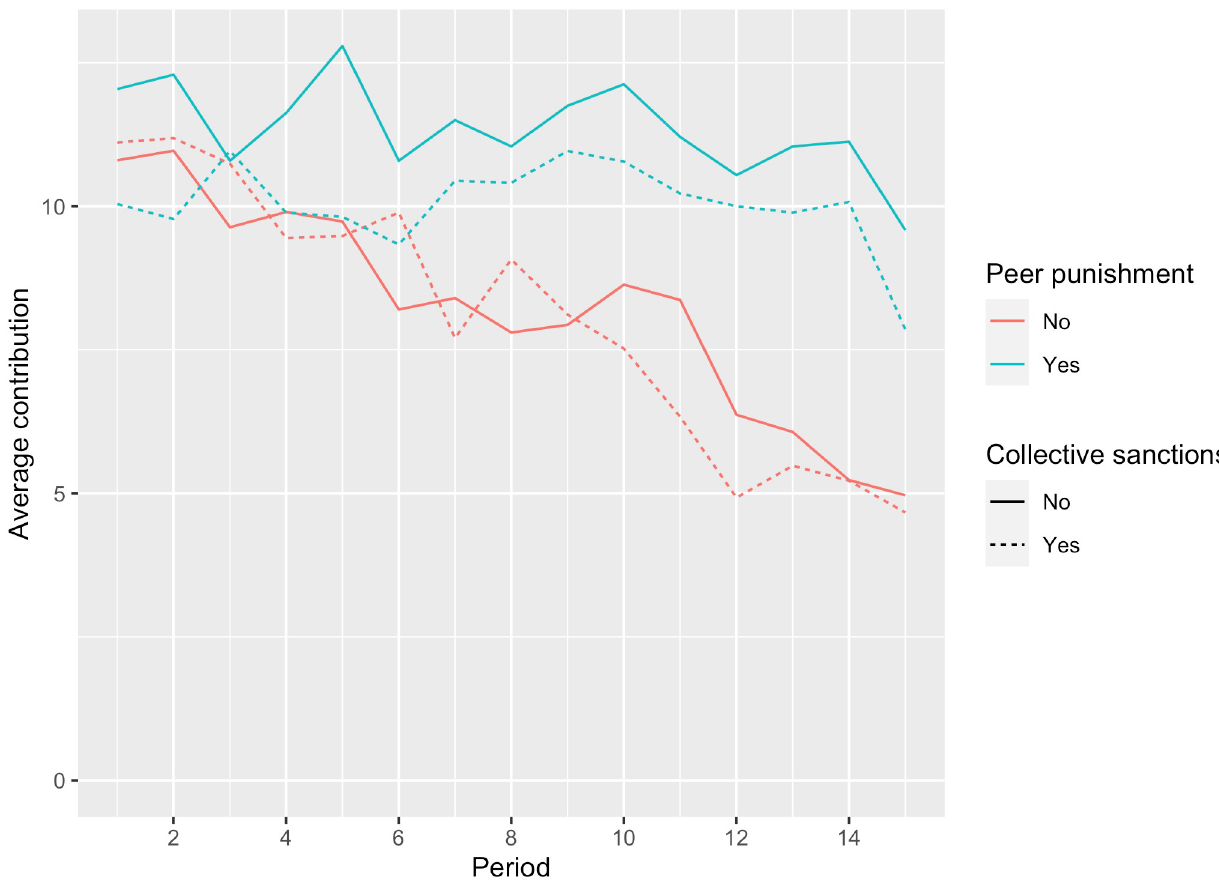
Fig 2. Average contribution per